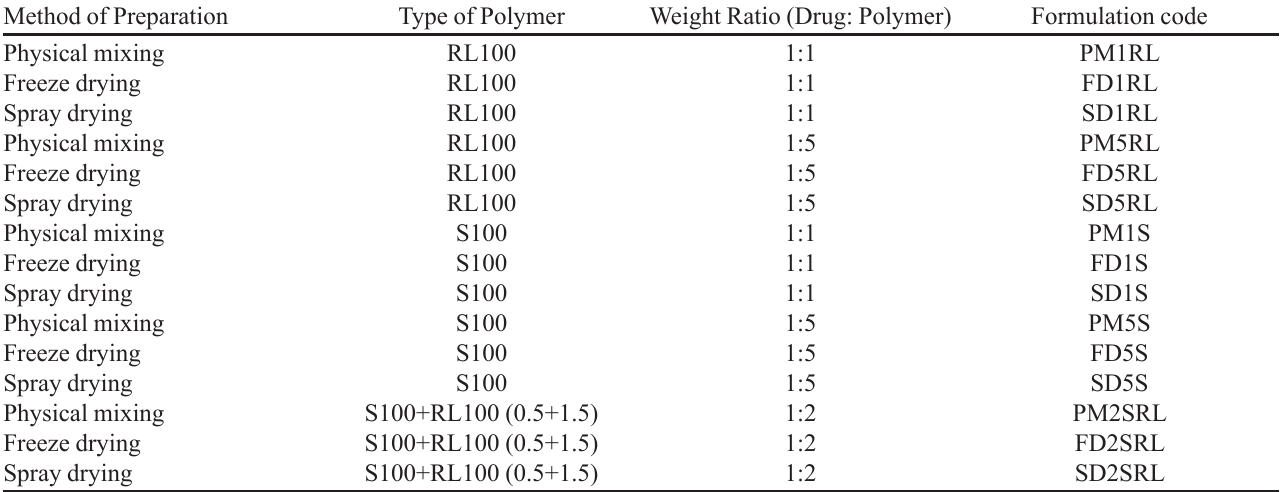
TABLE I - Formulation of PHC and Eudragit solid dispersion systems Method of